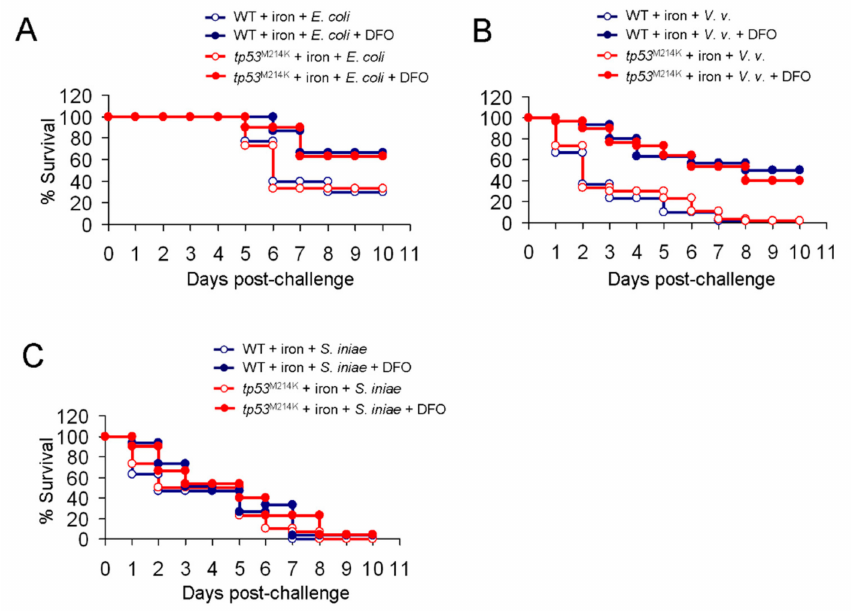
Figure 7. Survival to bacterial infection in iron-overloaded zebrafish carrying the tp53 M214K mutation vs. the WT. The Kaplan–Meier survival curve of iron dextran (50 µ g)-treated WT or tp53 M214K mutant zebrafish challenged with ( A ) E. coli (10 7 CFU), ( B ) V. vulnificus (10 5 CFU) or ( C ) S. iniae (10 3 CFU), with or without co-administration of deferoxamine (DFO, 7 µ g), n = 30 for each group, analyzed by the Kaplan–Meier log rank